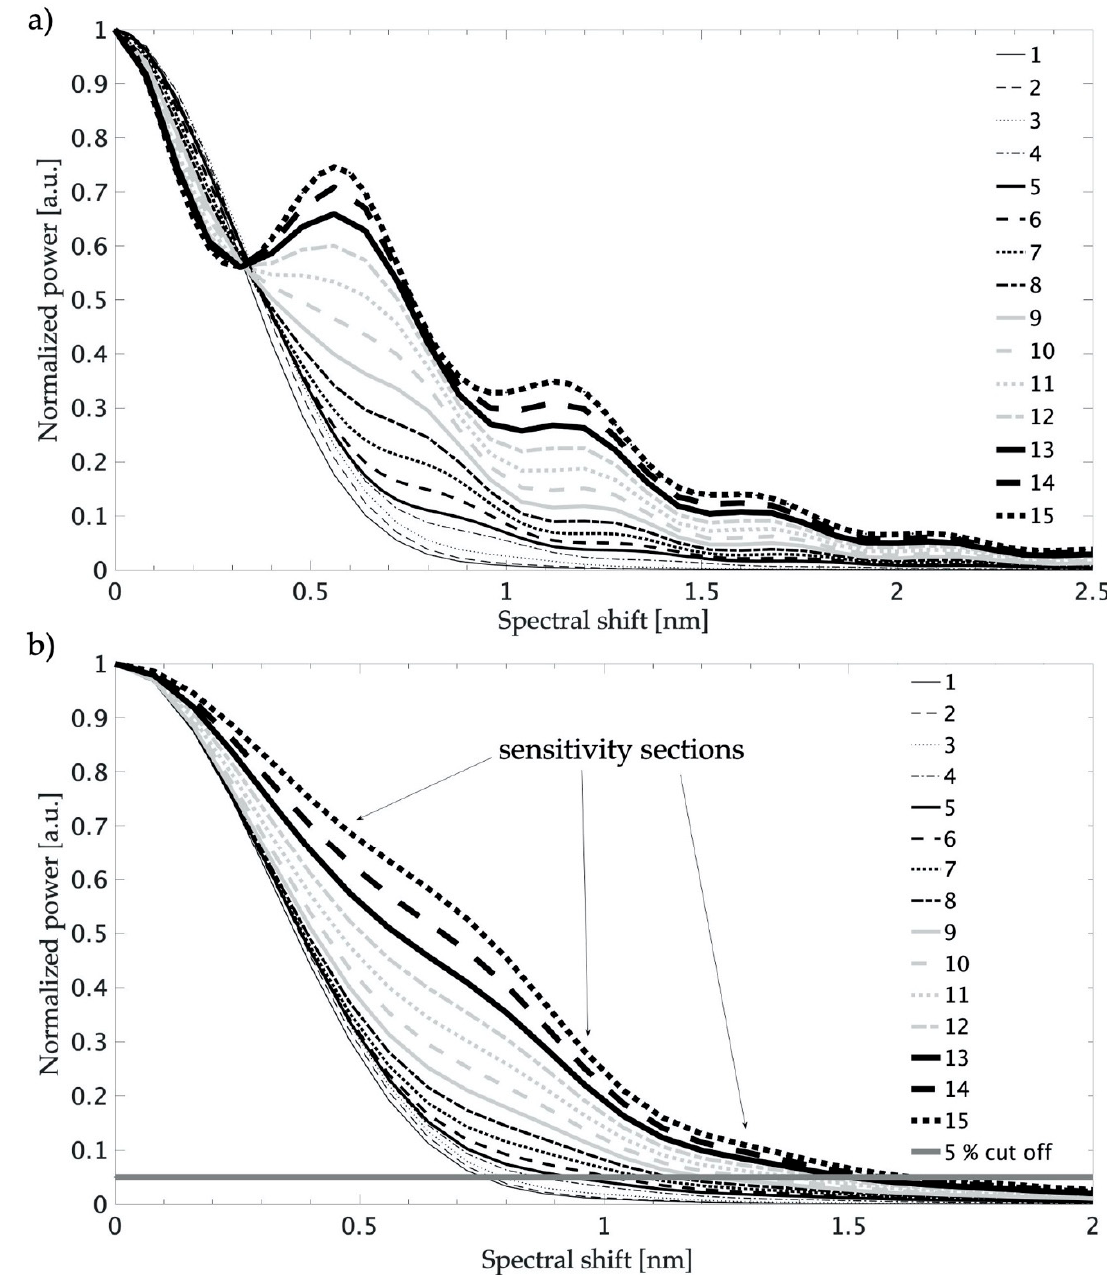
Figure 4. Comparison of the shape of the transfer characteristics of the matched filter system: ( a ) two similar structures; ( b ) uniform FBG1 with one of the FBG1–FBG15 filters.